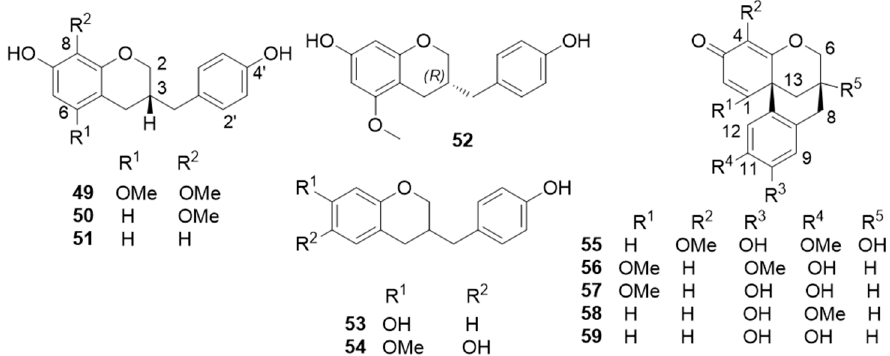
Figure 11. Selected homoisoflavans and meta-homoisoflavans from D. cochinchinensis red resin.